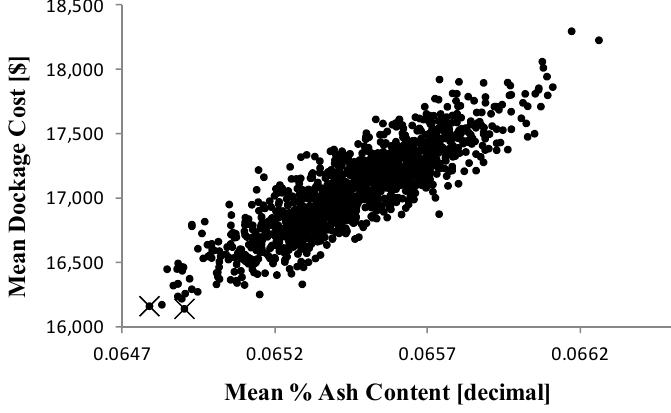
Figure 5. Scatter plot percentage of ash content vs. dockage cost (schedule (*)).